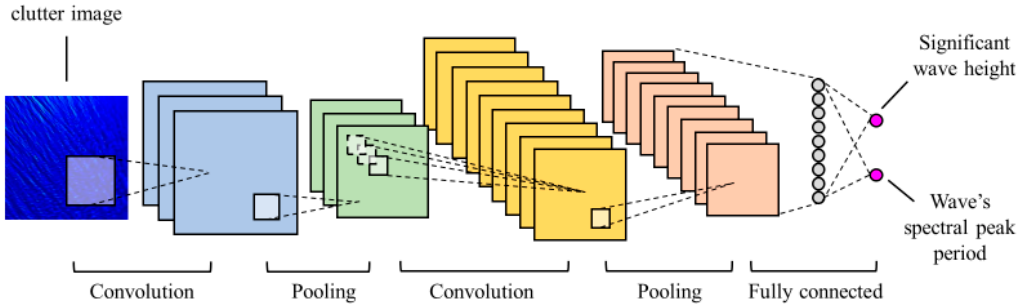
Figure 1. Process of extracting a radar image’s characteristics using CNN.